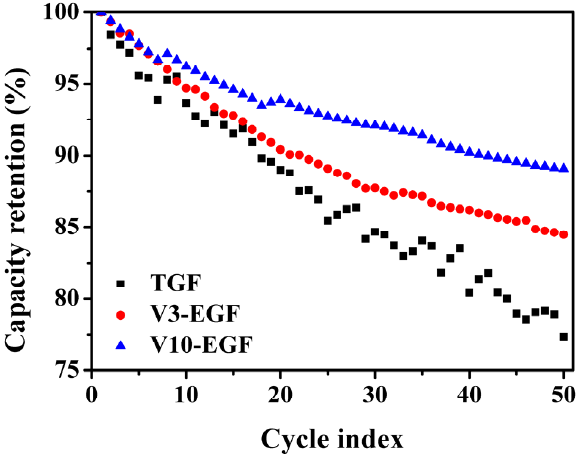
Figure 10. Capacity retention of VRFB with different GF electrodes at 150 mA cm − 2 during 50 cycles.